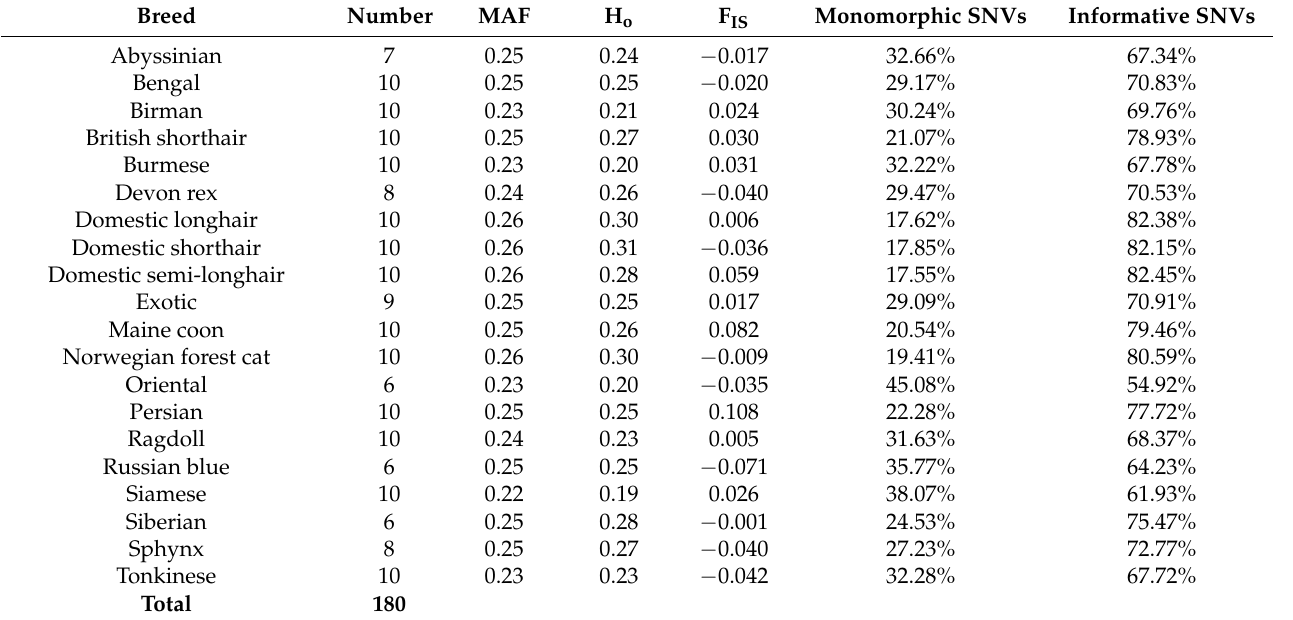
Table 3. A second dataset was extracted from the original clean dataset, containing only breeds with more than 5 samples, and for those breeds with more than 10 samples, the R function “sample_n” was used to select 10 samples at random from the